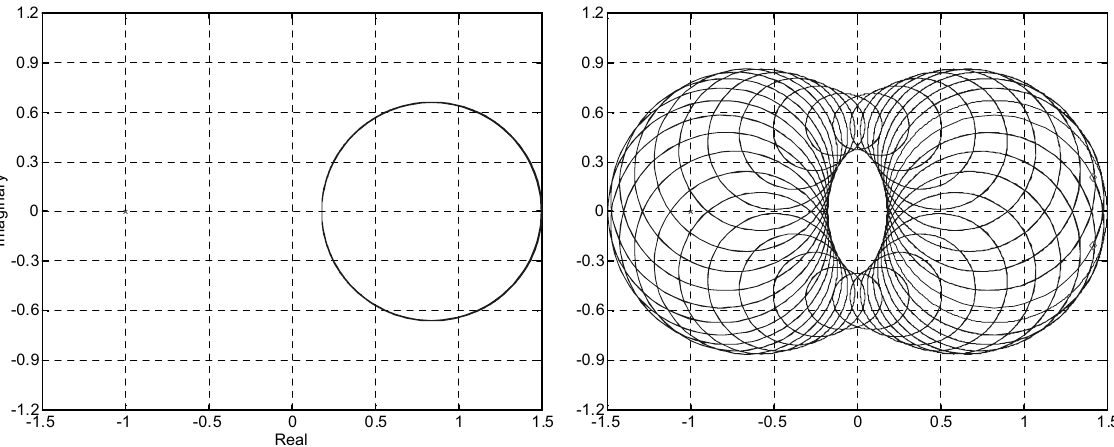
Fig. 4. Nyquist plot of a system with end dampers ( D 1 = D 2 = φ /4). Left – collocated, right – noncollocated ( β =